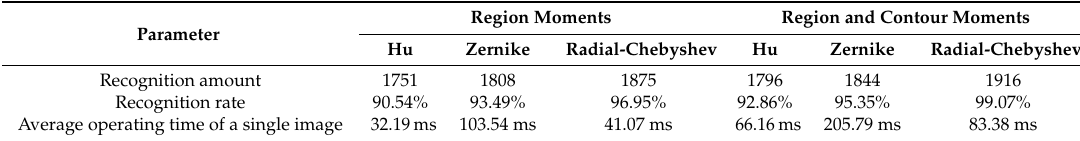
Table 4. Recognition results of the testing set in the first case